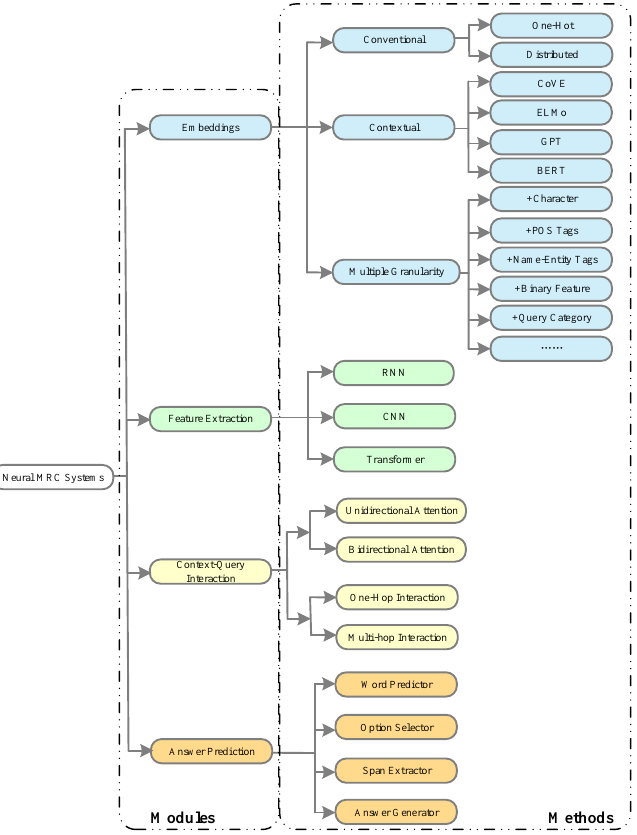
Figure 6. Typical techniques in neural MRC